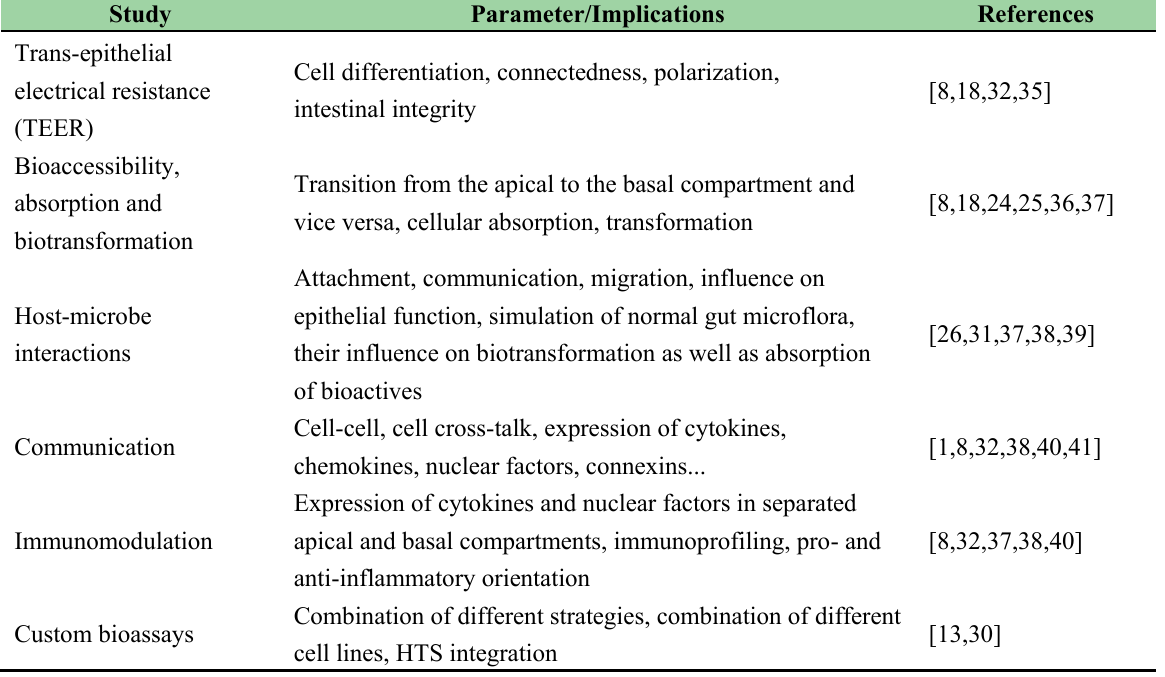
Table 2. Applicability of the 3D functional cell model of the